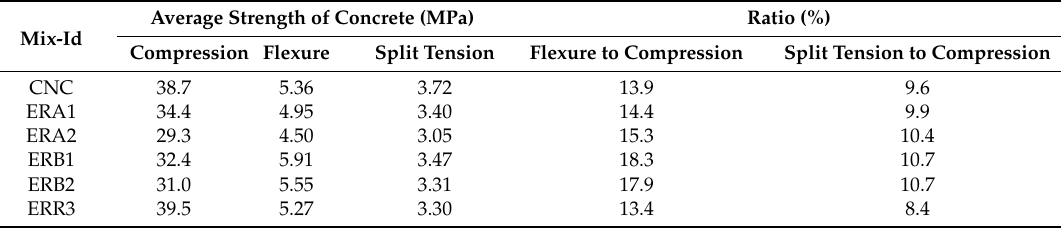
Figure 8. Flexural strength results of concrete samples ( a ) strength, ( b ) relative value of ERA series, ( c ) relative value of ERB series, and ( d ) relative value of ERR mix. Table 4. Relation between compressive, flexural, and split tensile strength of concrete; Mix-Id: mixture